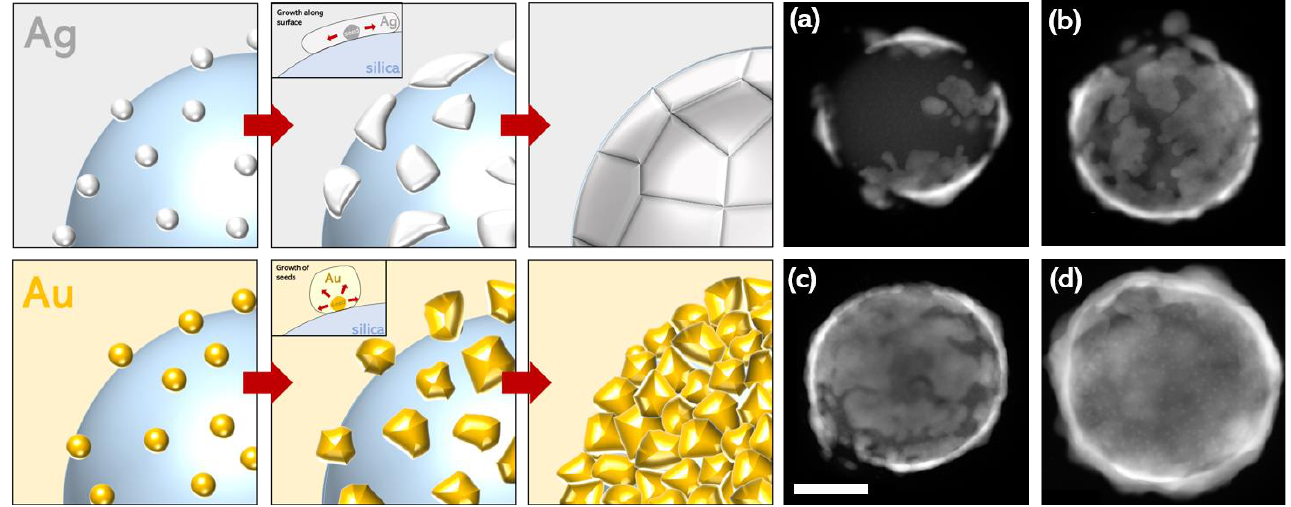
Figure 4. Schemes showing the formation mechanism for silver and gold nanoshells. In the case of silver, seeds initially form rapidly before growth as ultrathin patches along the surface of the silica before forming a continuous shell. In the case of gold, seeds nucleate and grow in size until forming a thicker continuous shell. ( a – d ) The TEM images representing the formation of ultrathin silver nanoshells, and HAADF STEM images showing the progressive growth of the silver shell on the silica particles. The shells in images ( a – c ) featured 20 μL AgNO 3 and ( d ) featured 50 μL AgNO 3 (a higher quantity of silver was required for complete shell formation).